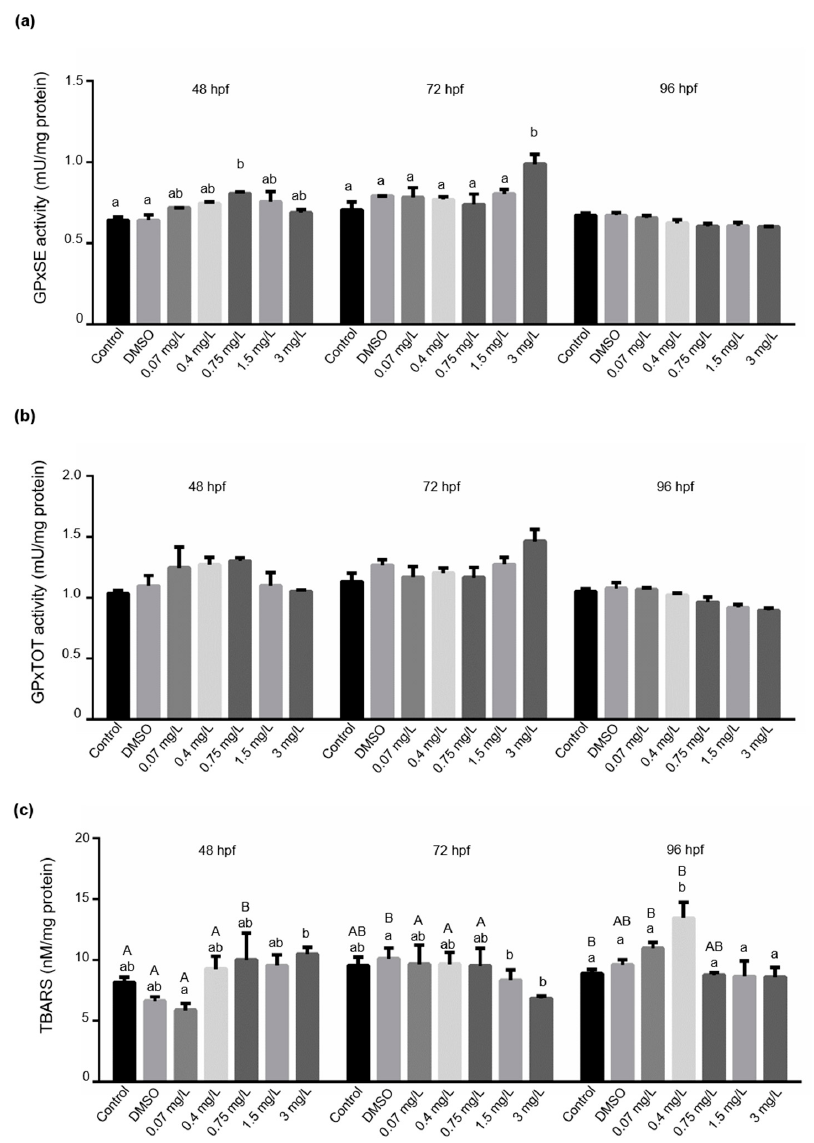
Figure 5. Effects of bendiocarb exposure on ( a ) GPx-SE activity, ( b ) GPx-TOT activity, and ( c ) LPO levels expressed as TBARS after 48, 72, and 96 h. Data represent the mean ± SD of two repeated test series. Different lower-case letters indicate significant differences between concentrations within each time point (Tukey-test after one-way ANOVA; p < 0.05; N = 42). Different upper-case letters indicate significant differences between time points within each concentration (Tukey-test after one-way ANOVA; p < 0.05).